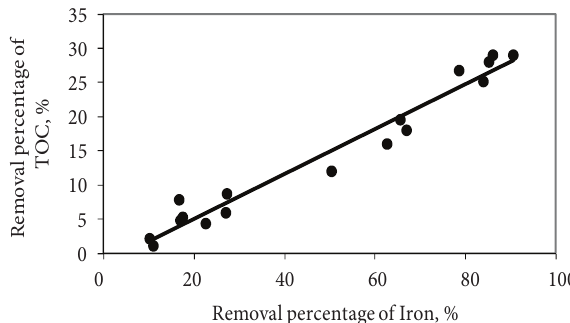
Figure 4. Dependence of the TOC reduction effectiveness on the effectiveness of removing total iron in water samples after the Ca(OH) 2 alkalinisation in the range of pH = 8.5÷10.5 and two-hour